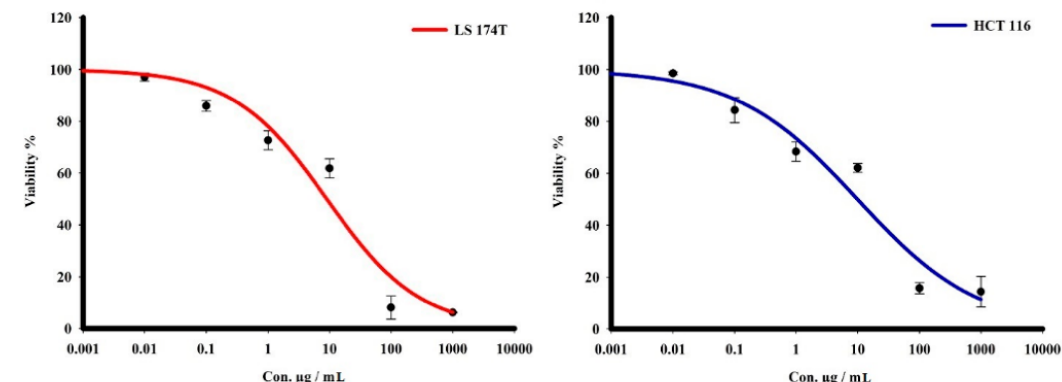
Figure 10. The dose-response curves of the cytotoxicity of L-glutaminase towards LS 174T and HCT 116 tumor cell lines. Cells were exposed to the enzyme with different concentrations for 72 h. Cell viability was determined by SRB stain.